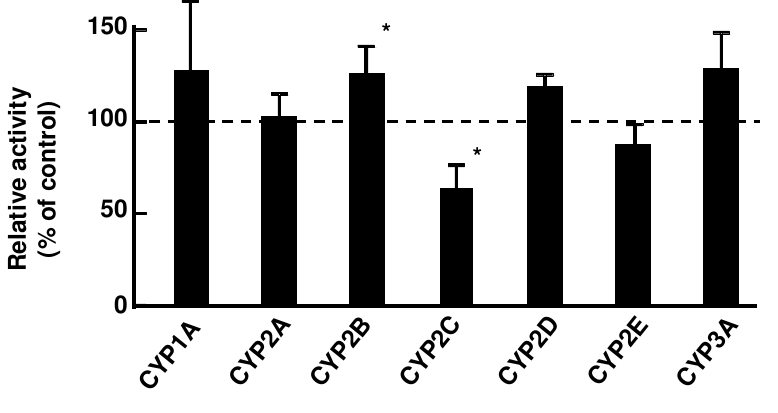
Figure 4. Liver microsomal P450-dependent activities after nicotine treatment. Control activities were taken from liver microsomes from untreated rats. Data columns with bars present means ± SDs (n = 4). Significant differences compared with the control activities: * p < 0.05.